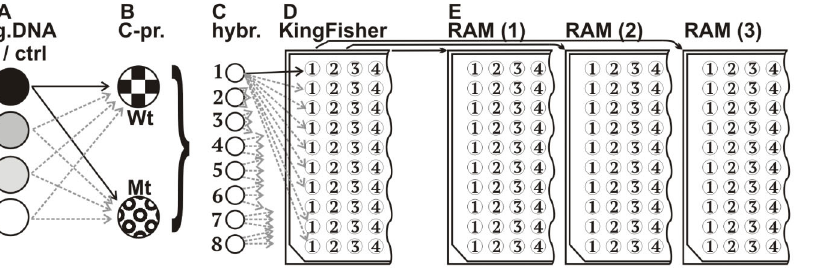
Figure 3. Experimental design for SNP assay. The figure represents a procedure that was followed on each of three days. (A) Three genotypes of genomic DNA or no-DNA control were combined with (B) each of two C-probes in (C) eight hybridization tubes. After hybridization, ten aliquots from each hybridization reaction were transferred to a Kingfisher plate (D). Following the automated process as described in the text, aliquots from each Kingfisher well were transferred into (E) three RAM reaction plates. Some arrows between steps A and B are in light gray for visual clarity. Each hybridization tube (C) was aliquoted into 10 wells in the KF plate (D); some arrows between (C) and (D) are shown shorter for visual clarity. The plate layouts are illustrated for conceptual clarity and do not correspond to physical